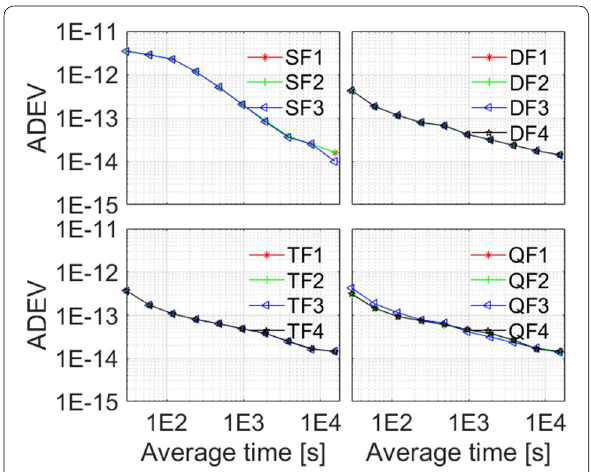
Fig. 6 Time series of the ZTD in BDS single-, dual-, triple- and quad-frequency PPP models at stations XIA3 on DOY 17,